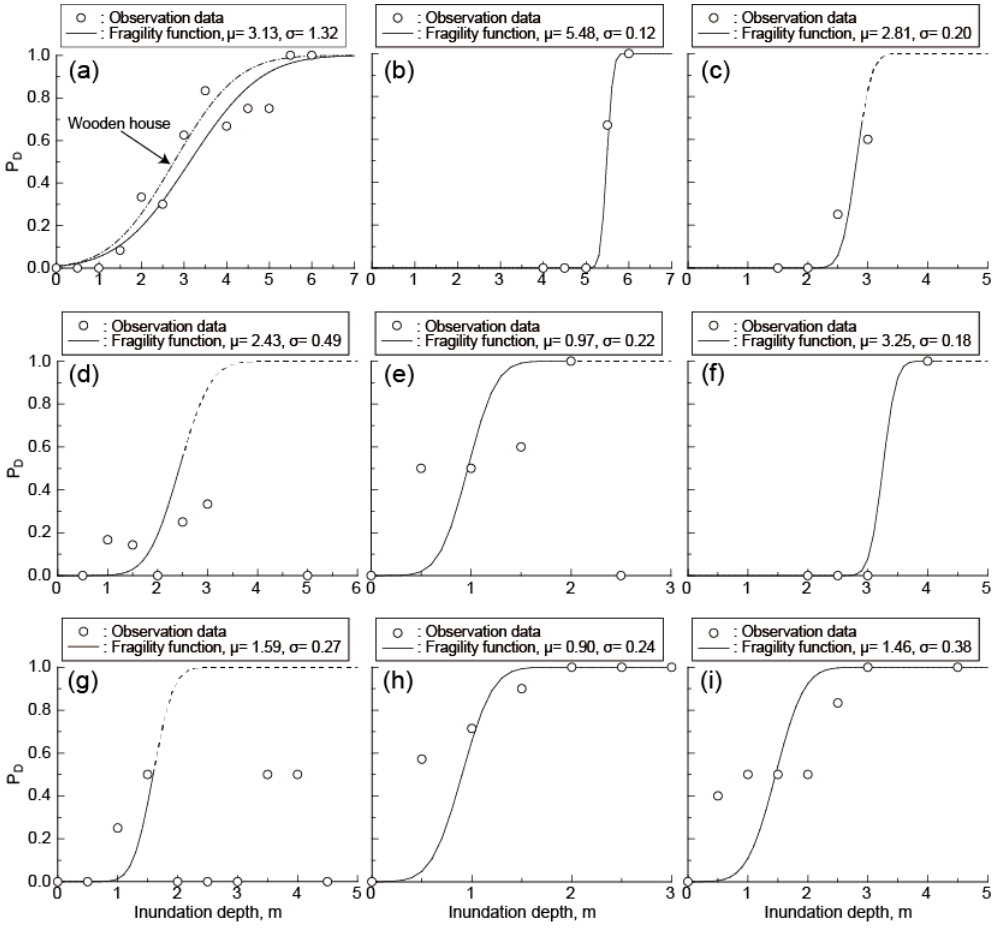
Figure 4. Fragility functions (damage probability P D versus inundation depth) for fishery port facilities and equipment. Circles indicate observed data, solid lines indicate the fragility function for each category, and dashed lines indicate extrapolation of the function. ( a ) Warehouses. The dash-dot line indicates the fragility function of wooden houses along straight coastlines during the 2011 Tohoku-oki earthquake tsunami [13]. ( b ) Landing and market facilities. ( c ) Freezer and refrigeration facilities, the dashed line is extrapolated and are not reliable. ( d ) Ice-making facilities, the dashed line is extrapolated and is also not reliable. ( e ) Water supply facilities. ( f ) Fueling facilities, the dashed line is extrapolated and is not reliable. ( g ) Overhead equipment, the dashed line is extrapolated and is not reliable. ( h ) Fishing gear. (i)